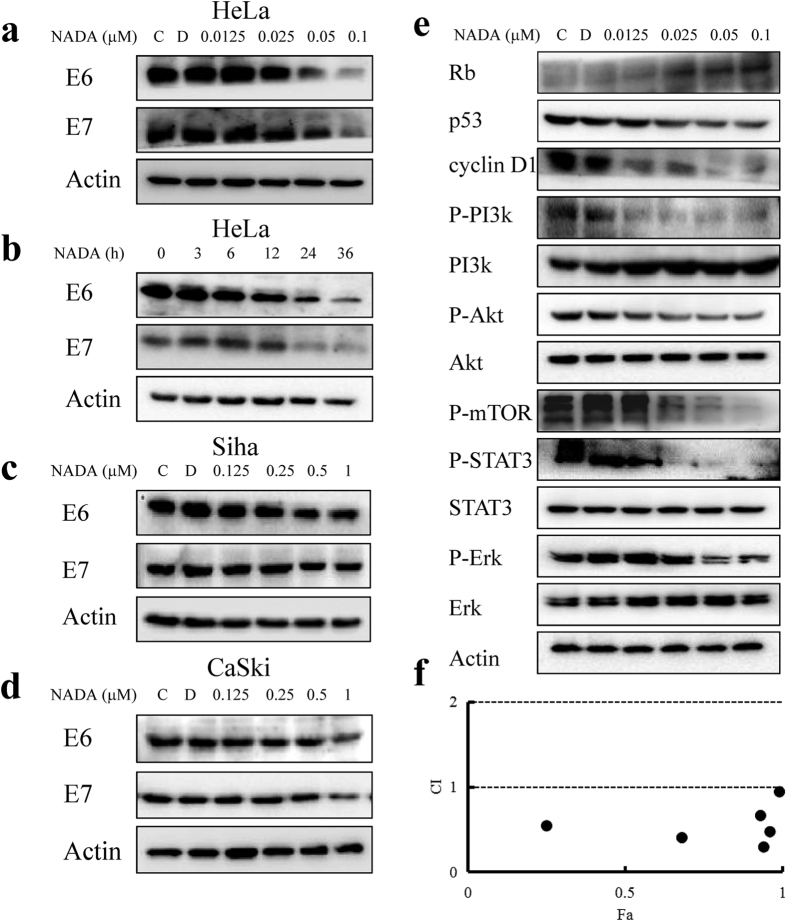
NADA induced E6/E7 viral oncoproteins degradation and depresses the function of E6/E7.(a) HeLa cells were treated with the indicated concentrations of NADA for 24 h. The expression levels of E6/E7 were assessed by western blotting. (b) HeLa cells were incubated with 0.1 μM NADA for the indicated times. The expression levels of E6/E7 were assessed by western blotting. (c) NADA induced E6/E7 degradation in Siha cells. (d) NADA induced E6/E7 degradation in CaSki cells. (e) HeLa cells were treated with the indicated concentrations of NADA for 24 h, and the E6/E7 relevant signaling molecules were assessed. Histograms show the quantity analyses for intensity of these bands in a-e are shown as Supplementary Fig. S2. (f) NADA showed synergistic effect with cisplatin. The combination index (CI) reflecting the synergism of two drugs was calculated using software package Calcusyn (Biosoft, Cambridge, UK). The CI values of < 1, 1, and > 1 indicate synergistic, additive, and antagonistic effects, respectively. All experiments were performed in three replicates (n = 3).